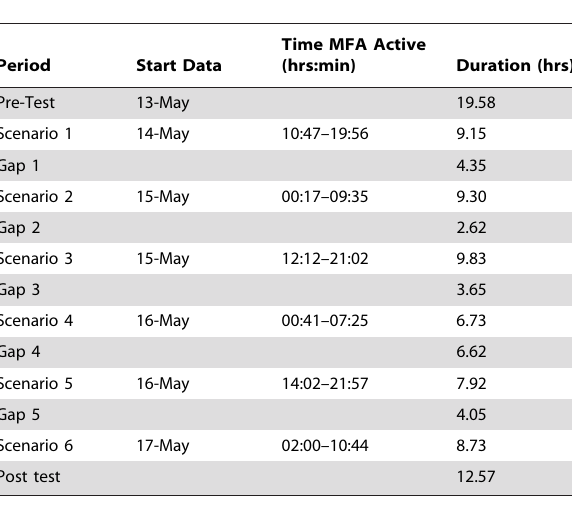
Table 1 . The start and stop times of six sonar scenarios during a multi-ship exercise on the AUTEC range in 2009 with the duration of gap periods with no